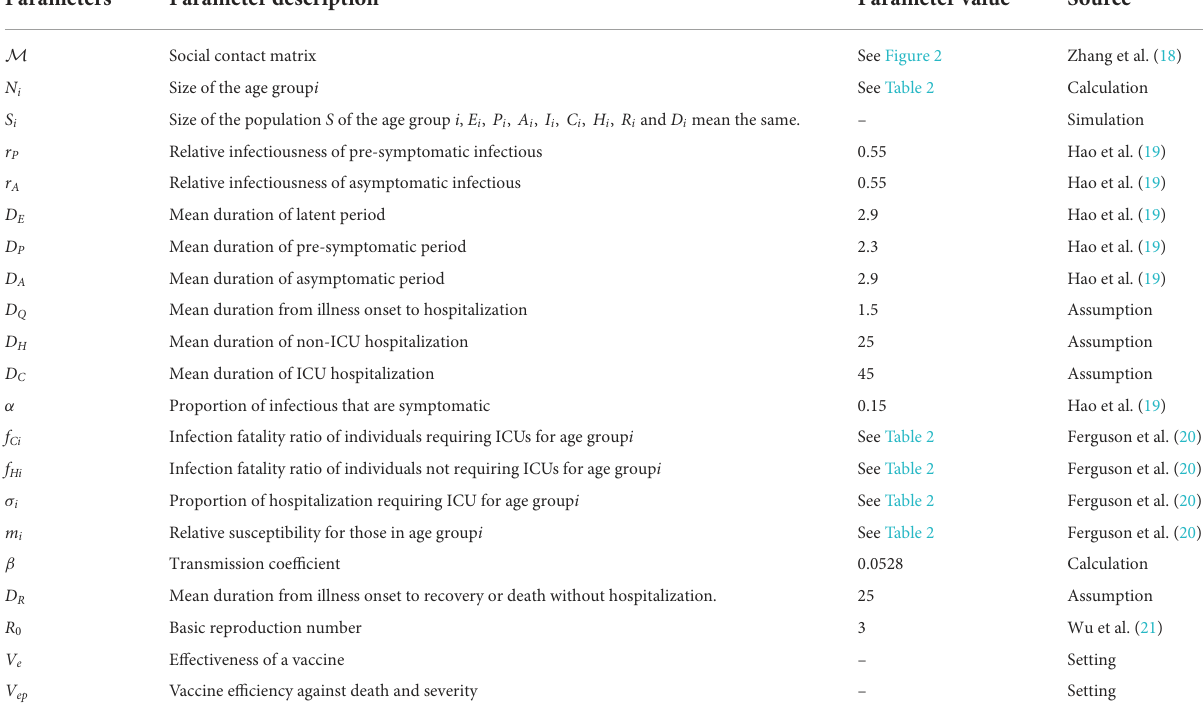
TABLE 1 Parameter descriptions of the extended age-stratified SEIR